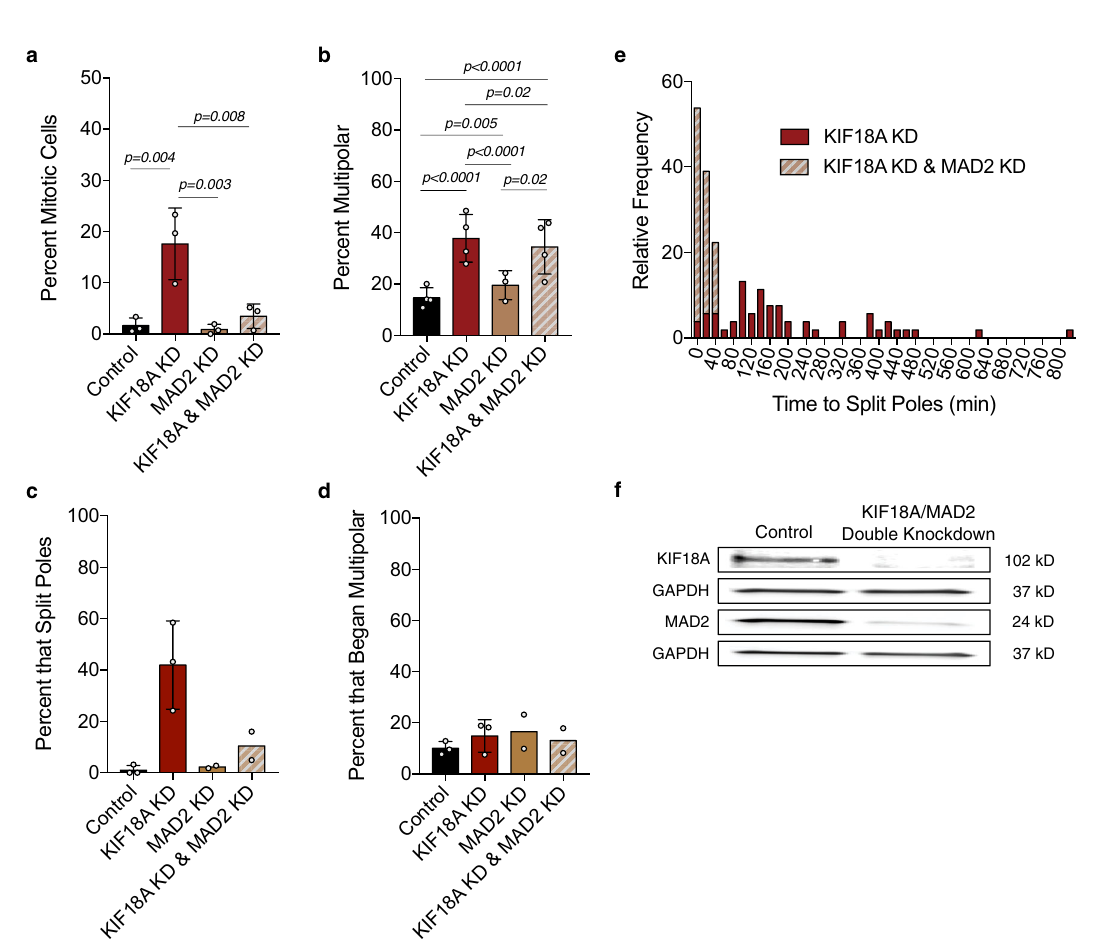
Fig. 5 Spindle checkpoint inhibition rescues mitotic arrest but not multipolar spindle formation caused by KIF18A KD. a , b Percent of fi xed MDA-MB- 231 cells ( a ) in mitosis or ( b ) with multipolar spindles after the indicated siRNA knockdown (KD). n = 3 independent biological samples for all conditions in a , and n = 3 (MAD2 KD) or 4 (control, KIF18A, and KIF18A & MAD2 KD) in b . Data were analyzed via one-way ANOVA with post hoc Tukey ’ s test for multiple comparisons ( a ) or two-sided Chi-square test ( b ). P values <0.05 are displayed. c , d Percent of live, siR-tubulin-labeled MDA-MD-231 cells that ( c ) split poles during mitosis or ( d ) entered mitosis with more than two spindle poles. n (number of cells/number of independent experiments) = 126/3 (control), 172/3 (KIF18A), 127/2 (MAD2), and 117/2 (KIF18A and MAD2). All bars represent mean, and error bars represent SD. Individual data points are shown. e Stacked histogram showing relative frequencies of the duration of time between NEB and pole splitting for siR-tubulin-labeled MDA-MB-231 cells following KIF18A KD or KIF18A and MAD2 KD. f Western blots of MAD2, KIF18A, and GAPDH following treatment with either a double dose of control siRNA or a combination of KIF18A and MAD2